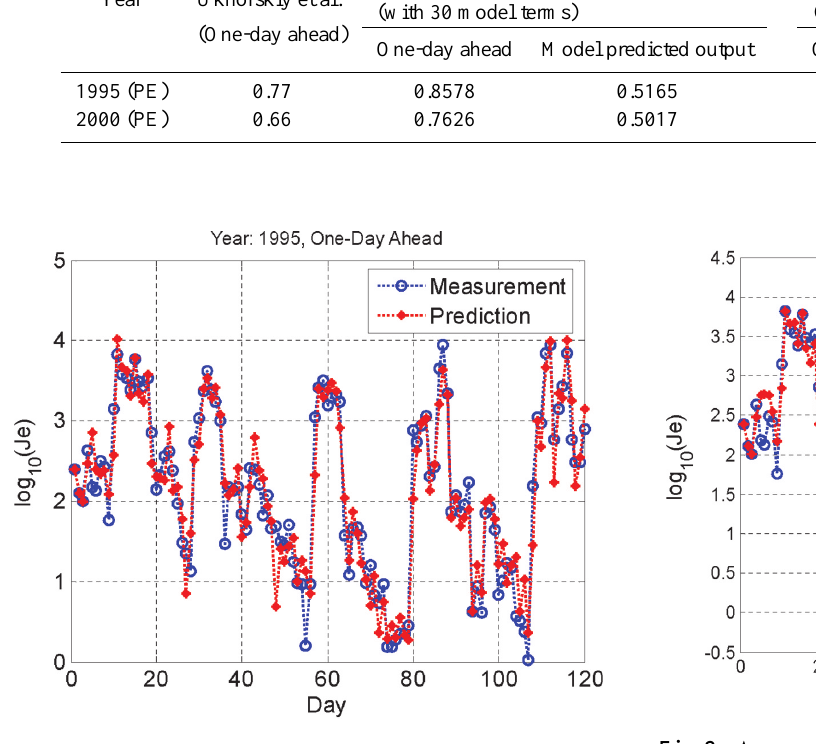
Fig. 1. A comparison between one-day ahead predictions and the corresponding measurements during a period in year 1995. Note that the model was generated from the initial full model structure with time lags up to m = 3.